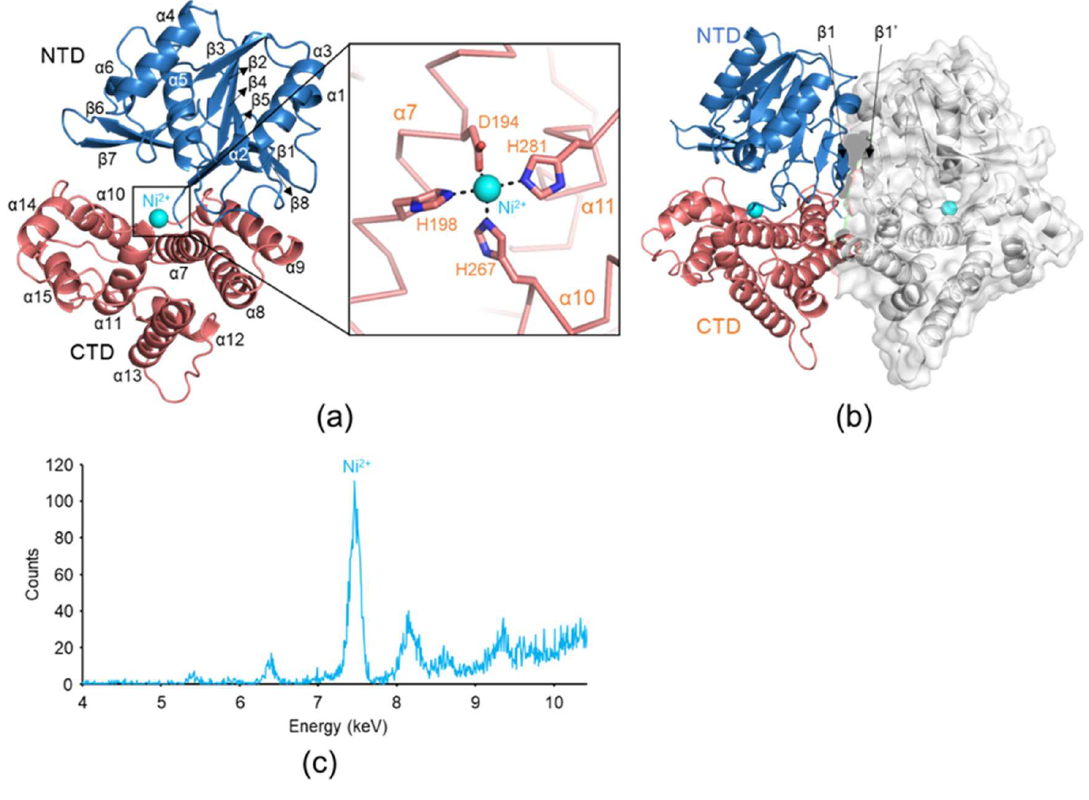
Figure 2. Ni 2+ ion binding by YugJ. ( a ) Overall structure of YugJ Ni and Ni 2+ ion coordination by YugJ residues. YugJ and Ni 2+ in the YugJ Ni structure are depicted as ribbons (NTD, light blue; CTD, light red) and a sphere (cyan), respectively. Ni 2+ ion coordination by the aspartate and histidine residues of YugJ is shown in a close-up view in the right panel. ( b ) Structure of the YugJ Ni dimer. One protomer is depicted as blue and red ribbons, and the other is shown as gray ribbons with gray transparent surfaces. The Ni 2+ ions are represented by cyan spheres. ( c ) X-ray fluorescence spectrum collected from a YugJ crystal. The peak at 7.46 keV is derived from Ni 2+ ions in the YugJ crystal.